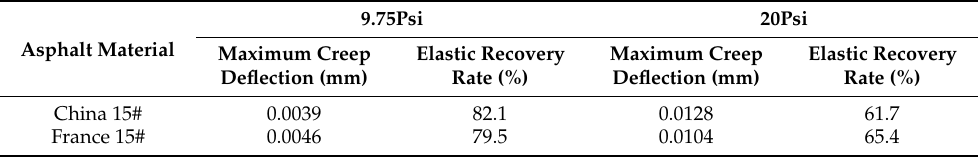
Table 3. Maximum deformation and elastic recovery rate.